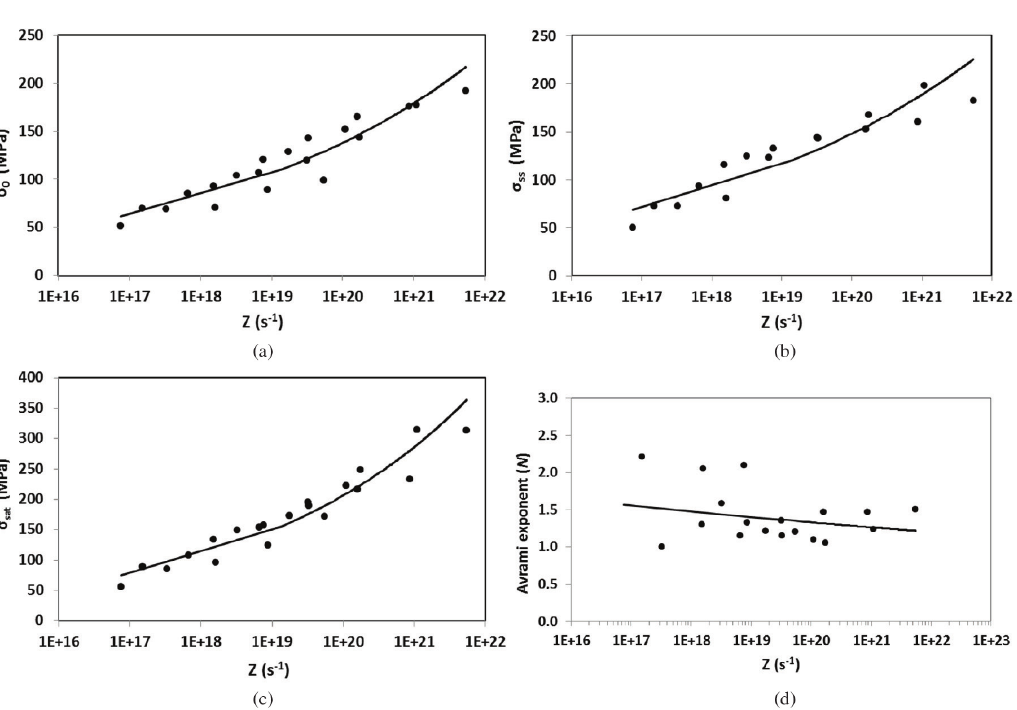
Figure 6. Dependence: (a) initial stress ( σ -Hollomon parameter